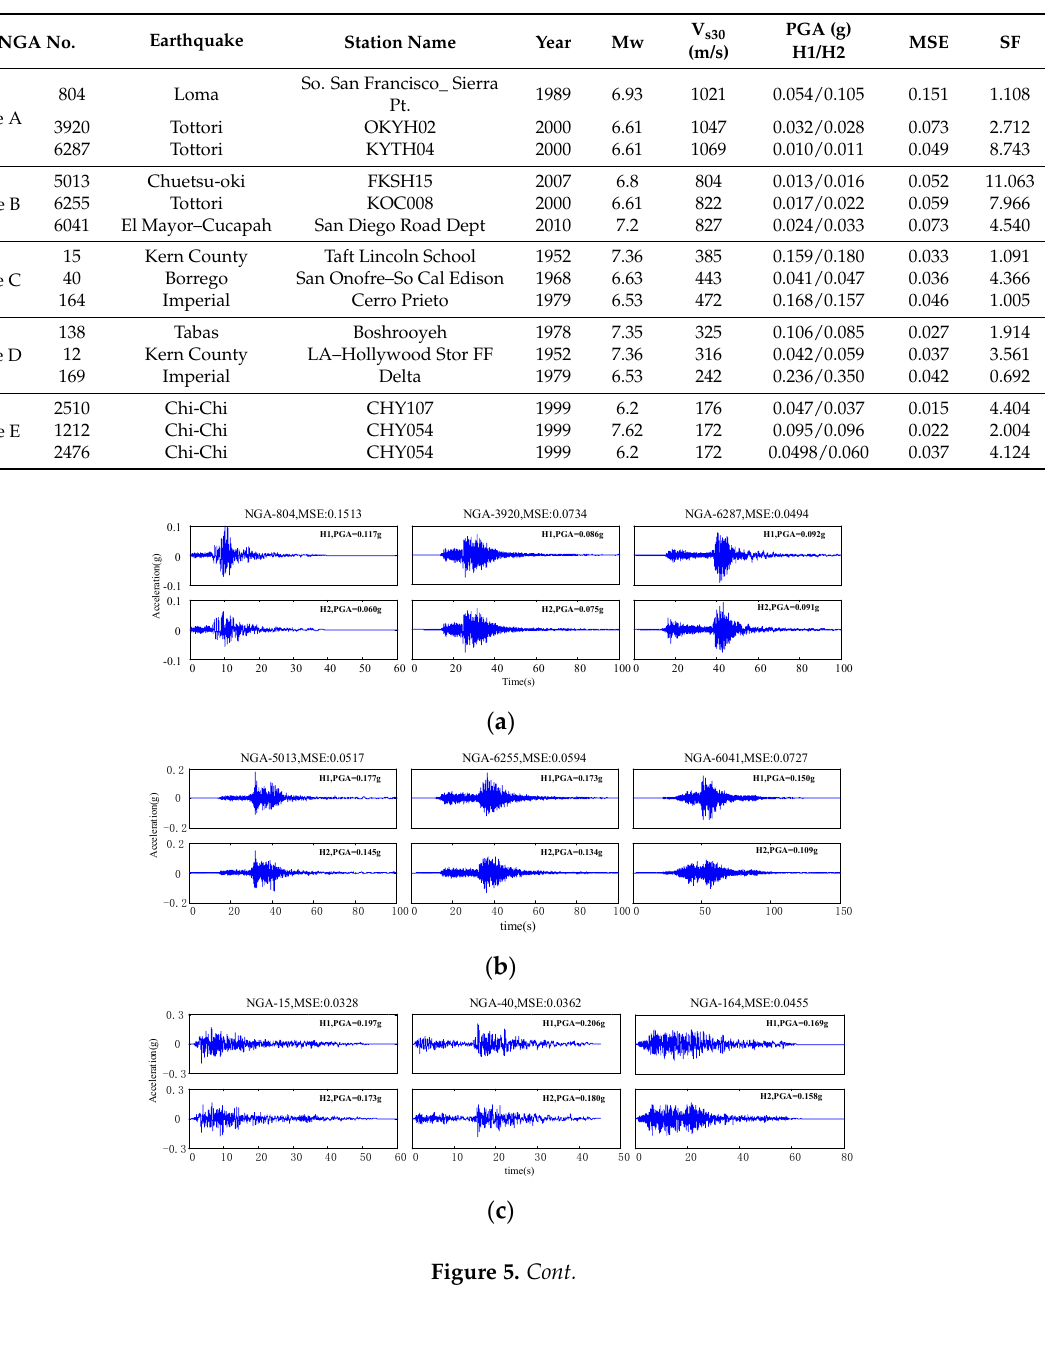
Table 4. Details of the selected PEER ground motion records.